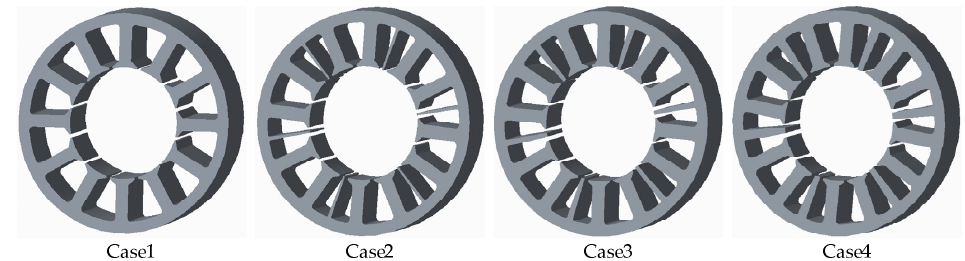
Figure 6. The model of the three-dimensional stator of PMSM.